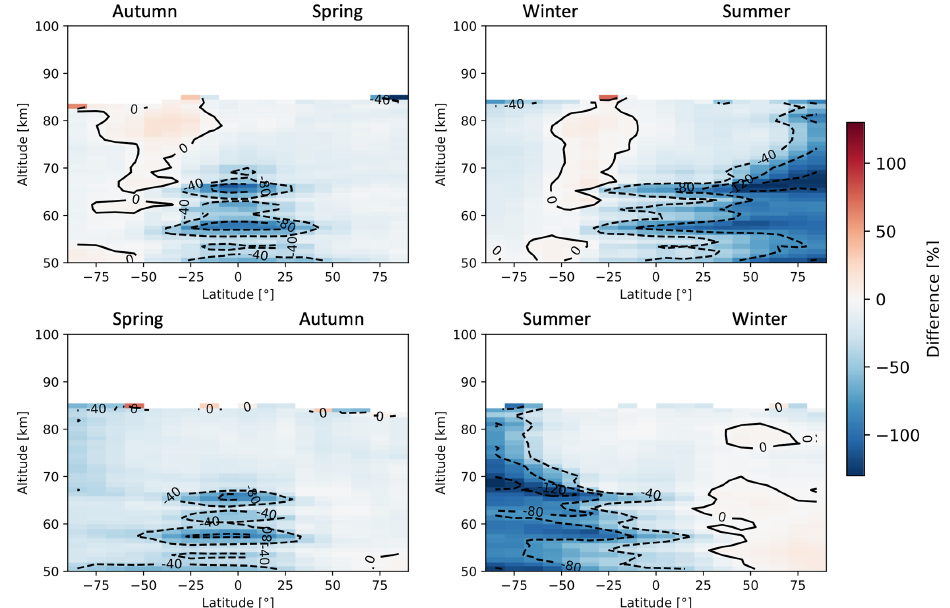
Figure A5. Seasonal zonal means of SMR–MLS relative differences averaged over the whole time between July 2004 and March 2019. The seasons are intended as the time between the solstice and the equinox. Note the different colour scale compared to the previous